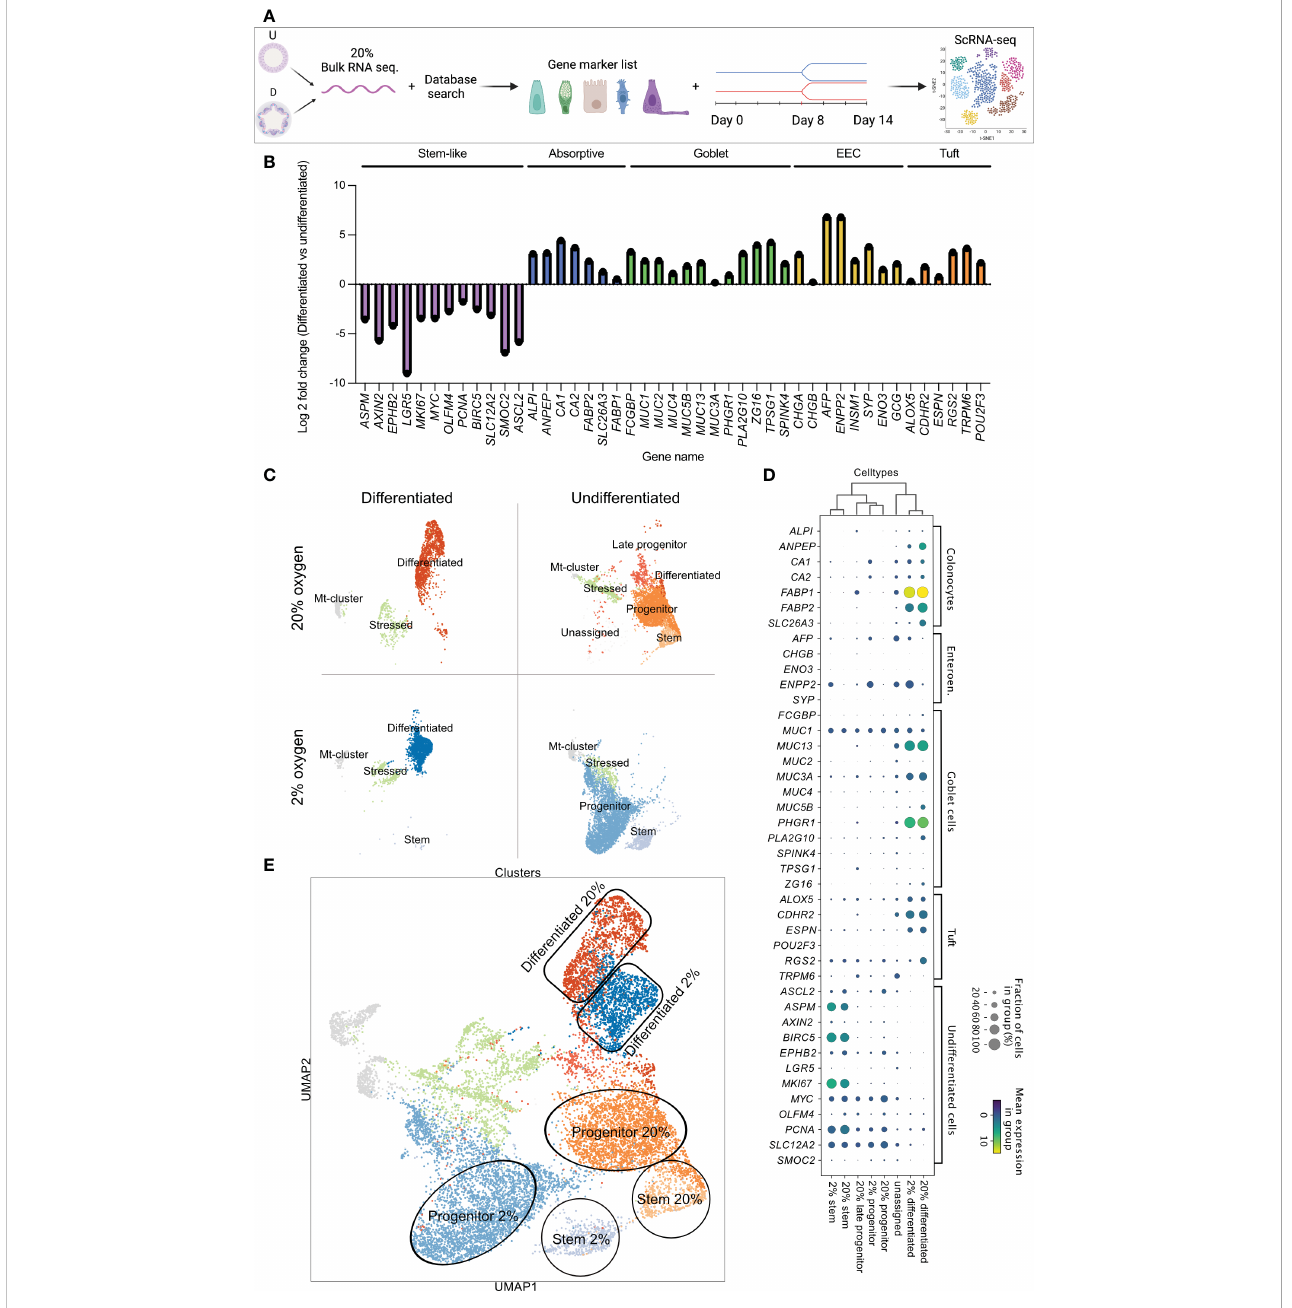
FIGURE 4 Identi fi cation of cell marker genes in undifferentiated and differentiated colonoids by bulk RNAseq (B) and single-cell RNAseq. (C-E) . (A) Schematic diagram of the experimental work fl ow. (B) Cell marker gene expression in differentiated vs . undifferentiated colonoids cultured in 20% oxygen. PangloaDB database (43) was used to identify cell marker genes, as described in the Method section. The x-axis shows gene names, and the y-axis shows the log2 foldchange for indicated genes in differentiated compared to undifferentiated colonoids (average of n=3). Cell marker genes are grouped and colored by cell type; purple for stem cells, blue for absorptive cells, green for goblet cells, yellow for enteroendocrine, and orange for tuft cells. (C) Visualization plot of scRNA-seq data from 13904 single cells. Four culture conditions (differentiated and undifferentiated in 2% and 20% oxygen) were analyzed in separate batches represented by their own UMAP-plot. The gene list con fi rmed in Bulk RNAseq (B) and SF1, sheet 10 was used to identify and annotate each cluster. (D) Dot plot showing expression of cell marker genes in the different cell clusters. Cell clusters are listed along the x-axis, while cell marker genes are listed along the y-axis. The color intensity represents mean expression within a cluster, and the radius of the dot represents the fraction of cells in the cluster expressing a gene. (E) Combined UMAP-plot for all four conditions. Clusters with equal annotations are illustrated by the circles (Stem cells), rectangles (Differentiated cells), and oval shapes (Progenitor cells) and color-coded as in